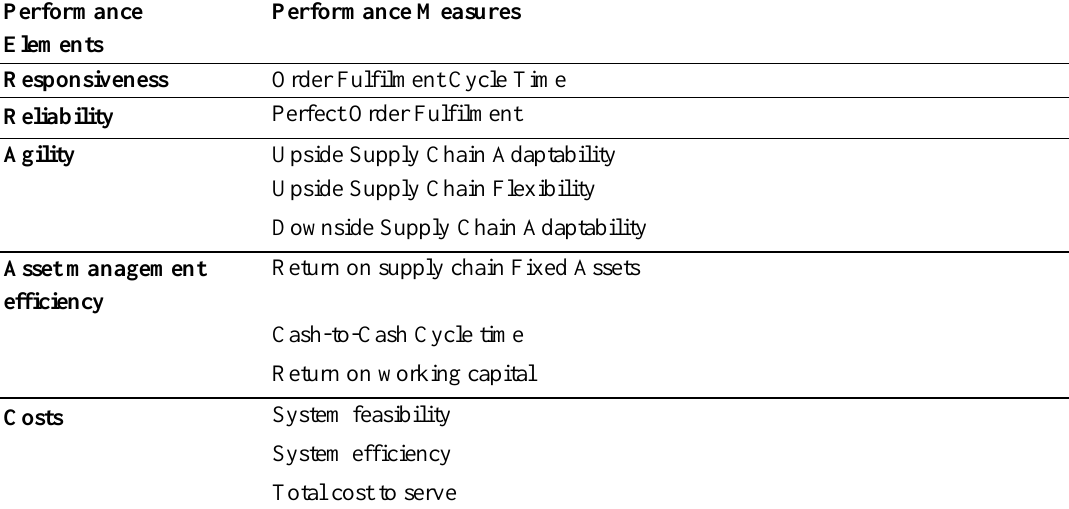
Table.2. The Proposed Qualities and Degrees for Gauging E-waste Supply